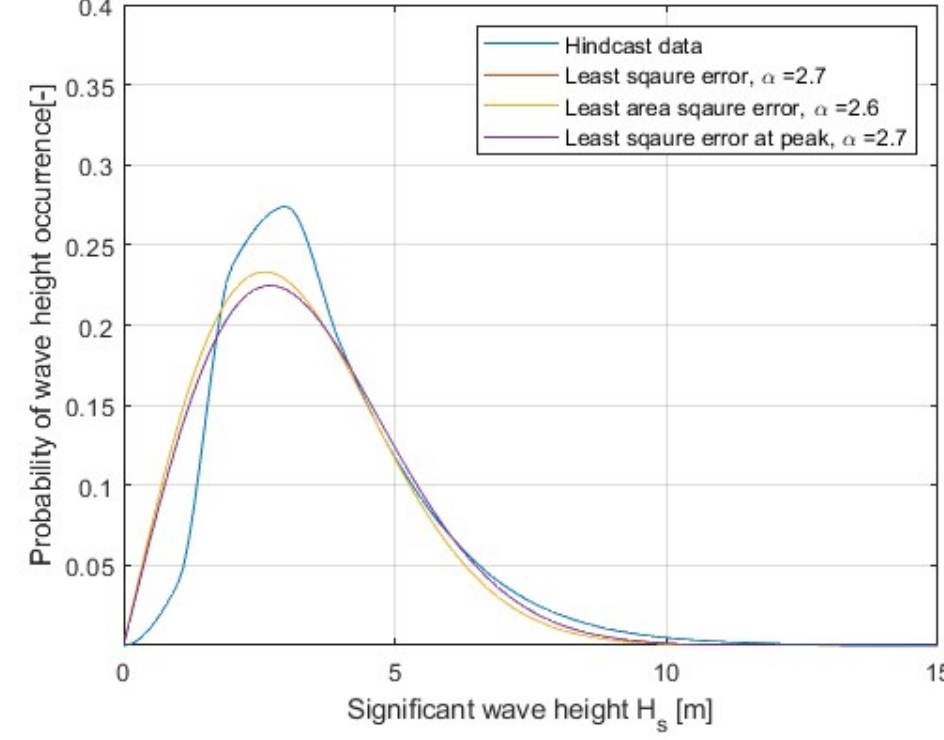
Figure 8. Plots of WST mean sea pdf (sea area S—full year). Table 4. Rayleigh shape parameter for full